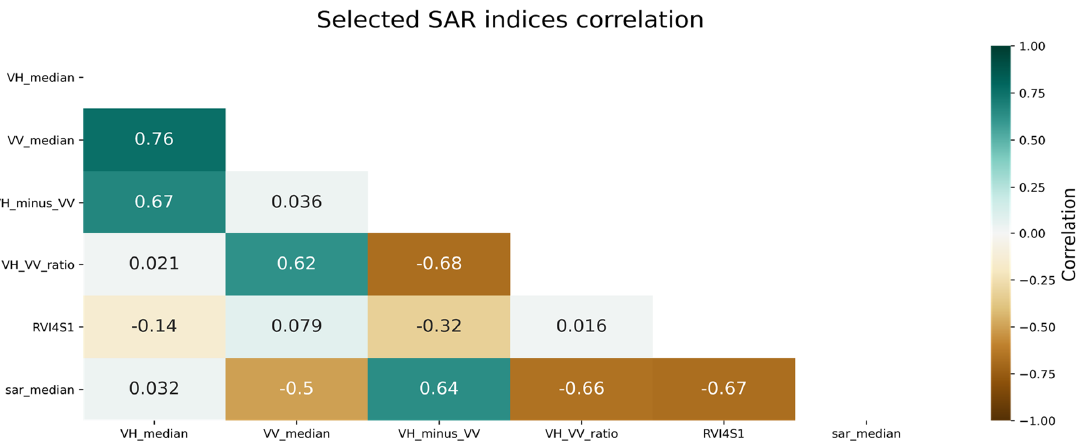
Figure 3. Correlation between the six SAR indices with low correlation between them.